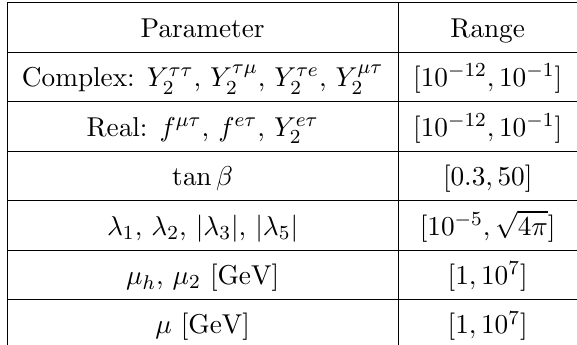
, Y (cid:28)(cid:22) , Y (cid:28)e , and Y (cid:22)(cid:28) , 2 2 2 2 can be assumed to be 2